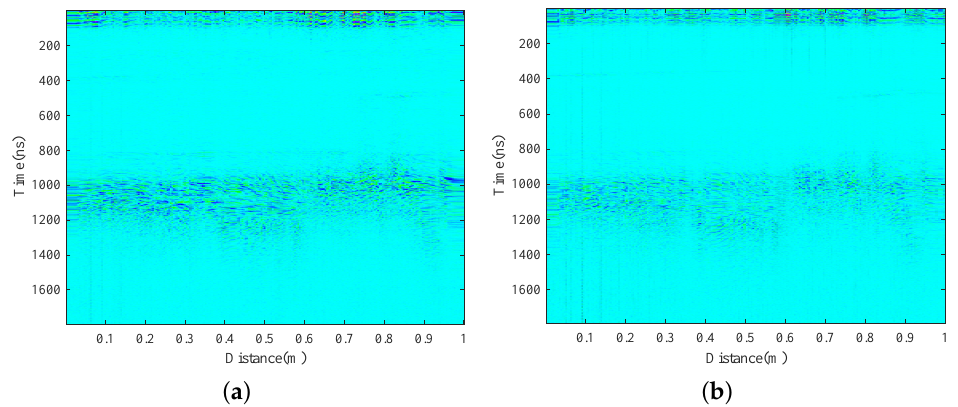
Figure 24. Glacier profiles of IMF1 and IMF2 combined after WOA-VMD-BD processing. ( a ) HH polarization mode. ( b ) HV polarization